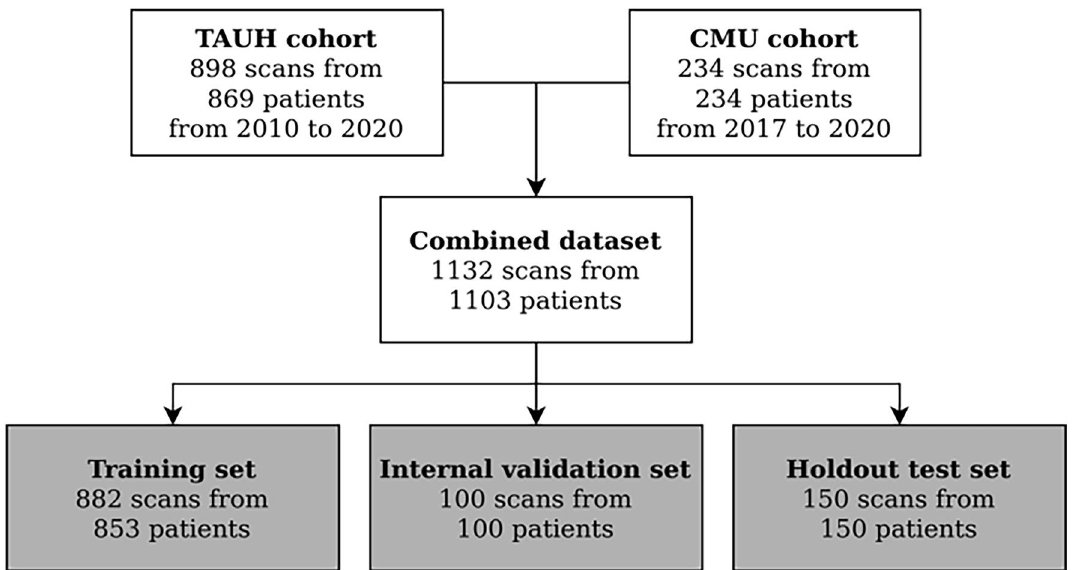
Figure 1. Flowchart for data collection. Patients were selected from recent clinical workflows at the Cranio and Dentomaxillofacial Radiological Department of the University Hospital of Tampere, Finland (TAUH), and from the Department of Oral Radiology, Faculty of Dentistry, Chiang Mai University (CMU), Thailand. Combined dataset had a total number of 1132 scans from 1103 patients that were split into a training set, internal validation set, and holdout test set with 853, 100, and 150 patients,